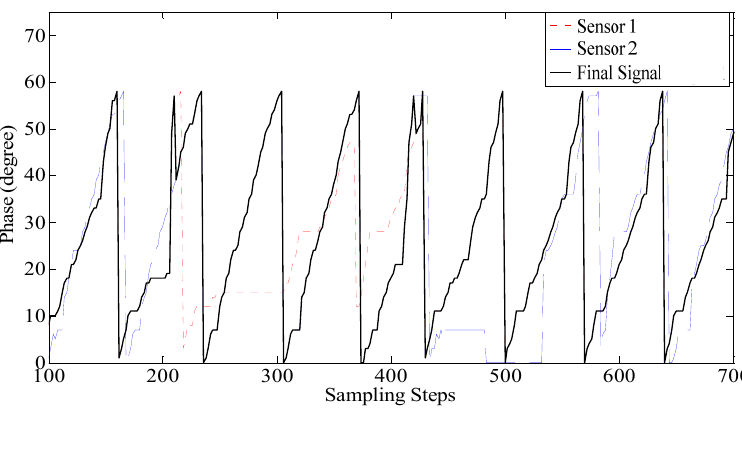
Figure 12. The experimental results of the two-modular